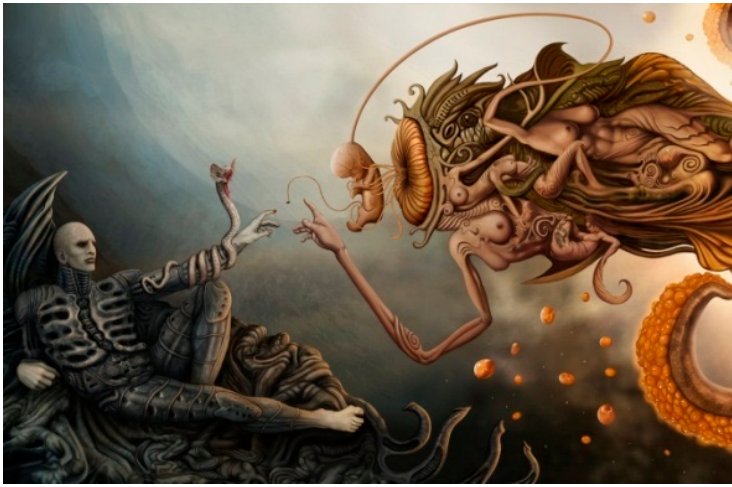
Figure 7. “Prometheus and God” by Dejano23. Courtesy of the author.